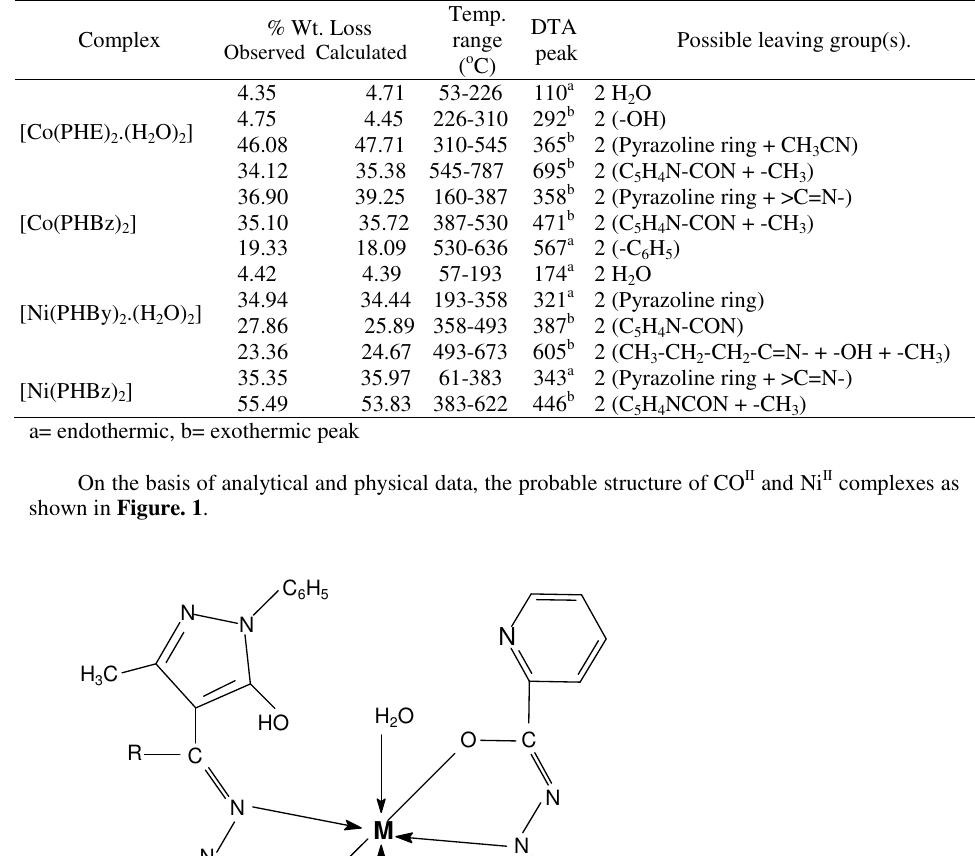
Table 4 . Thermo analytical data of some Co II and Ni II complexes